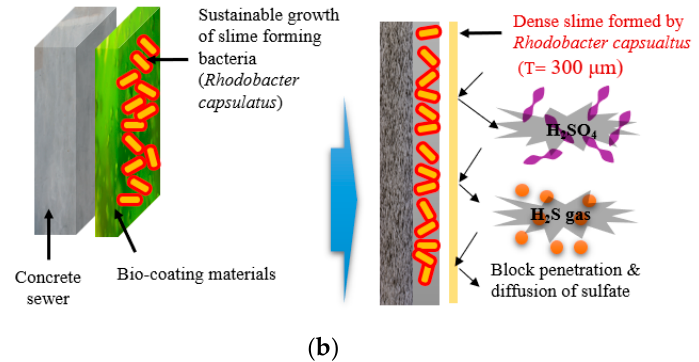
Figure 5. Schematic design for repair with bacteria and RC sewage structure: ( a ) RC culvert with bacteria coating repair; ( b ) Metabolism of resistance to sulfate attack by bacteria-formed slime.